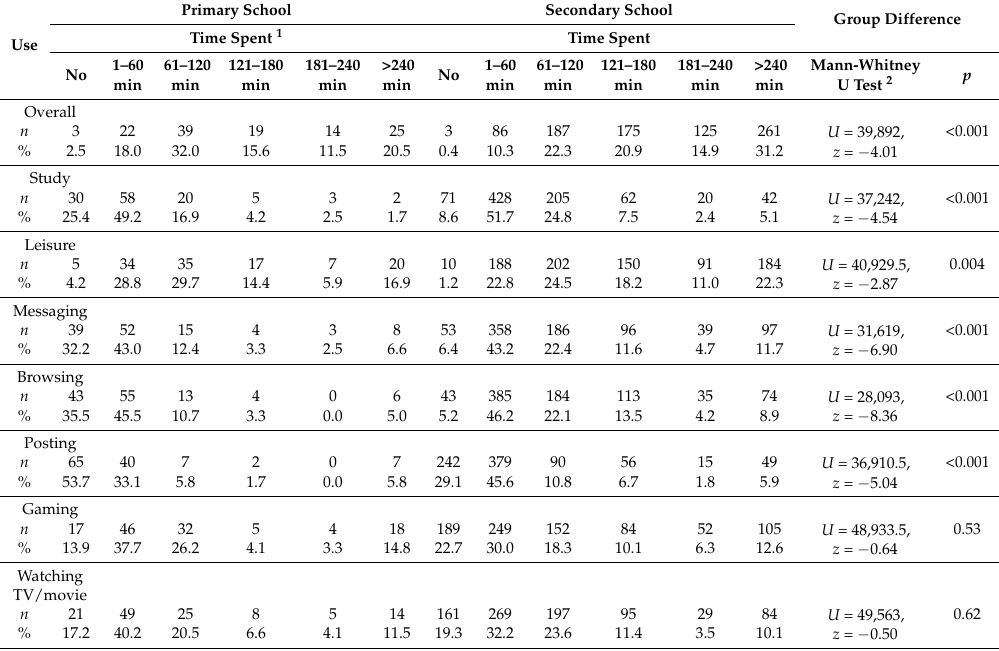
Table 4. Differences in time spent on smart device activities, overall use and its purposes between primary and secondary school